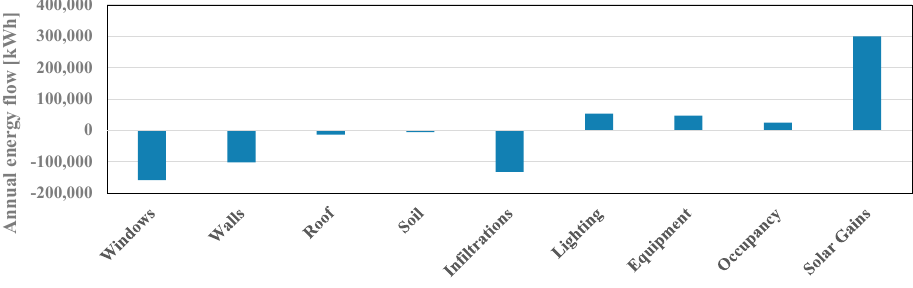
Figure 6. Estimated annual flows of energy for the current building.